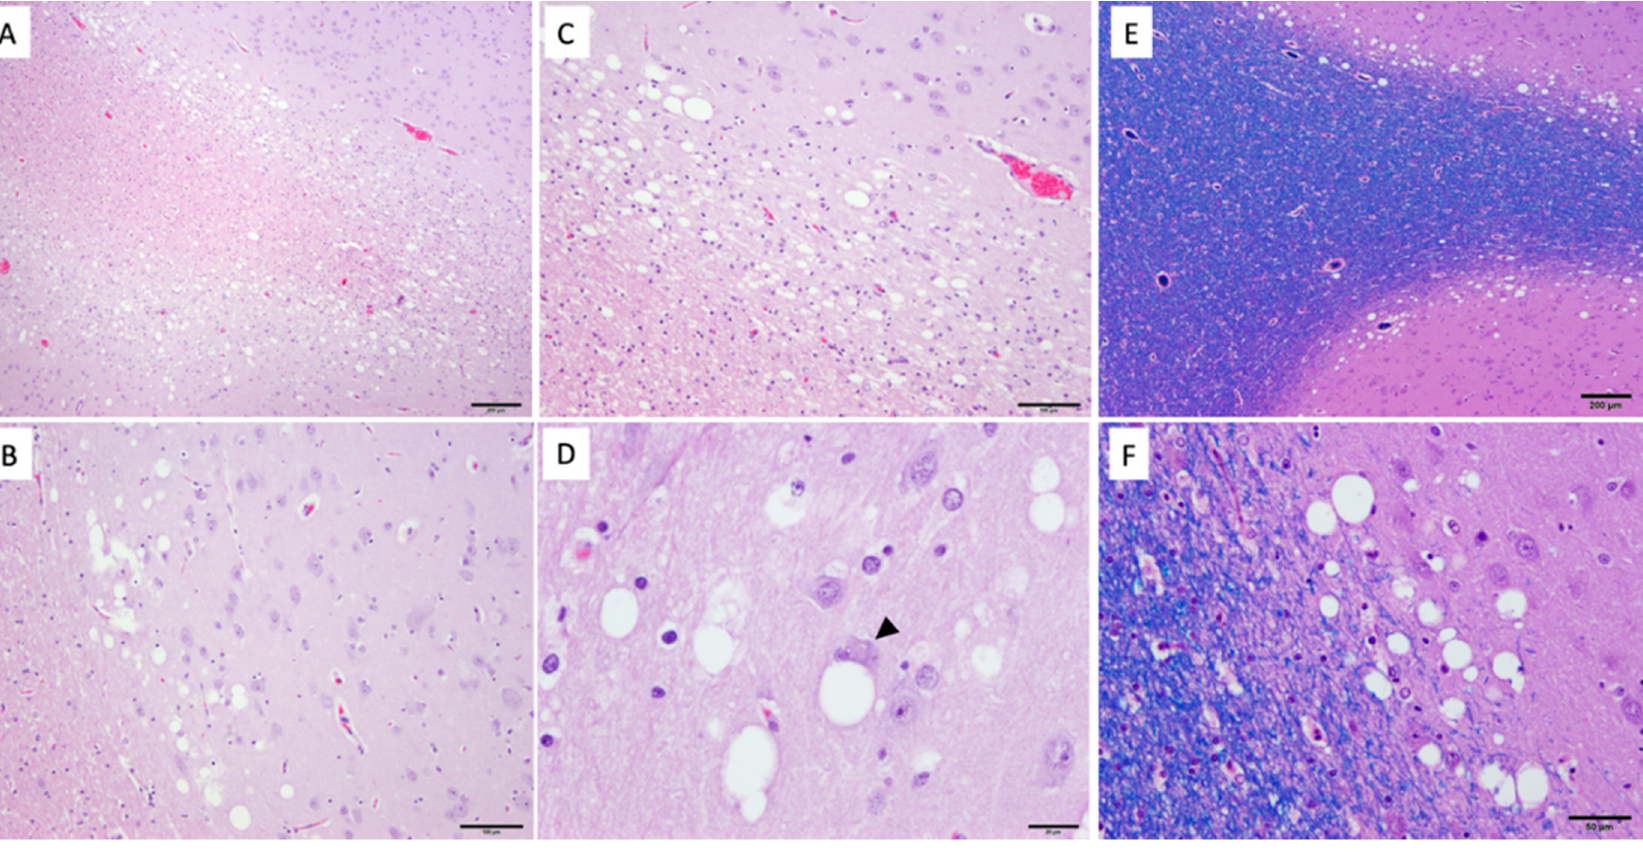
Figure 4. Histopathology of forebrain from dog 1. ( A ) Within the frontal cortex, the grey matter is predominantly affected by spongiotic change, with gliosis. ( B ) The spongiosis within the forebrain is most severe in the deep laminar cortex. ( C ) The caudate nucleus is also affected at the grey–white matter junction. ( D ) Affected neurons are characterized by enlarged, vacuolated cytoplasm with a peripheralized nucleus (arrowhead). Luxol fast blue (LFB) staining highlights the deep cortical nature of the vacuolation ( E ) within the cerebrum. ( F ) Vacuolation is discrete and often displaces cellular nuclei LFB staining.